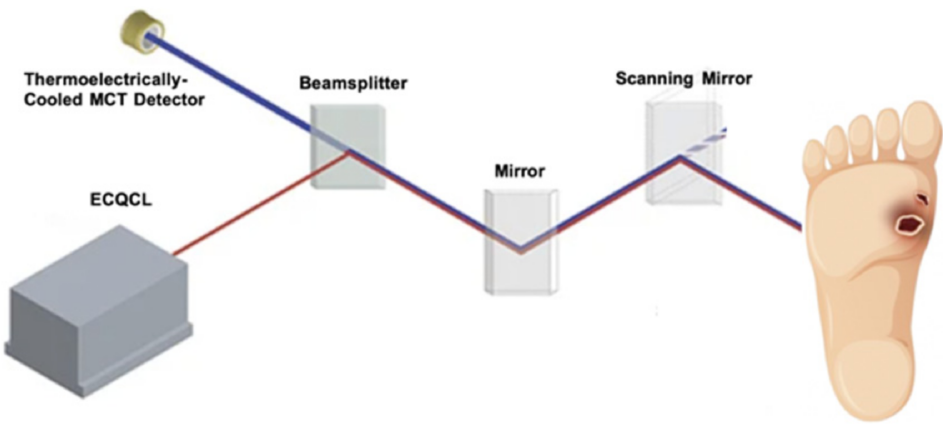
Figure 8. Laser Direct InfraRed (LDIR)